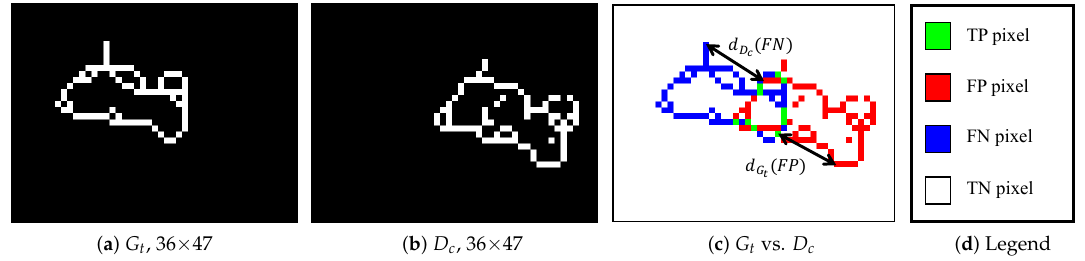
Figure 1. Example a ground truth G t and a desired contour D c . For each FN point, the minimum distance between the considered FN and D c is recorded, called d D the minimum distance between the considered FP and G t is recorded, called d G ( TP ) = 0 and d ( TP ) = for a TP pixel, both d D G t c